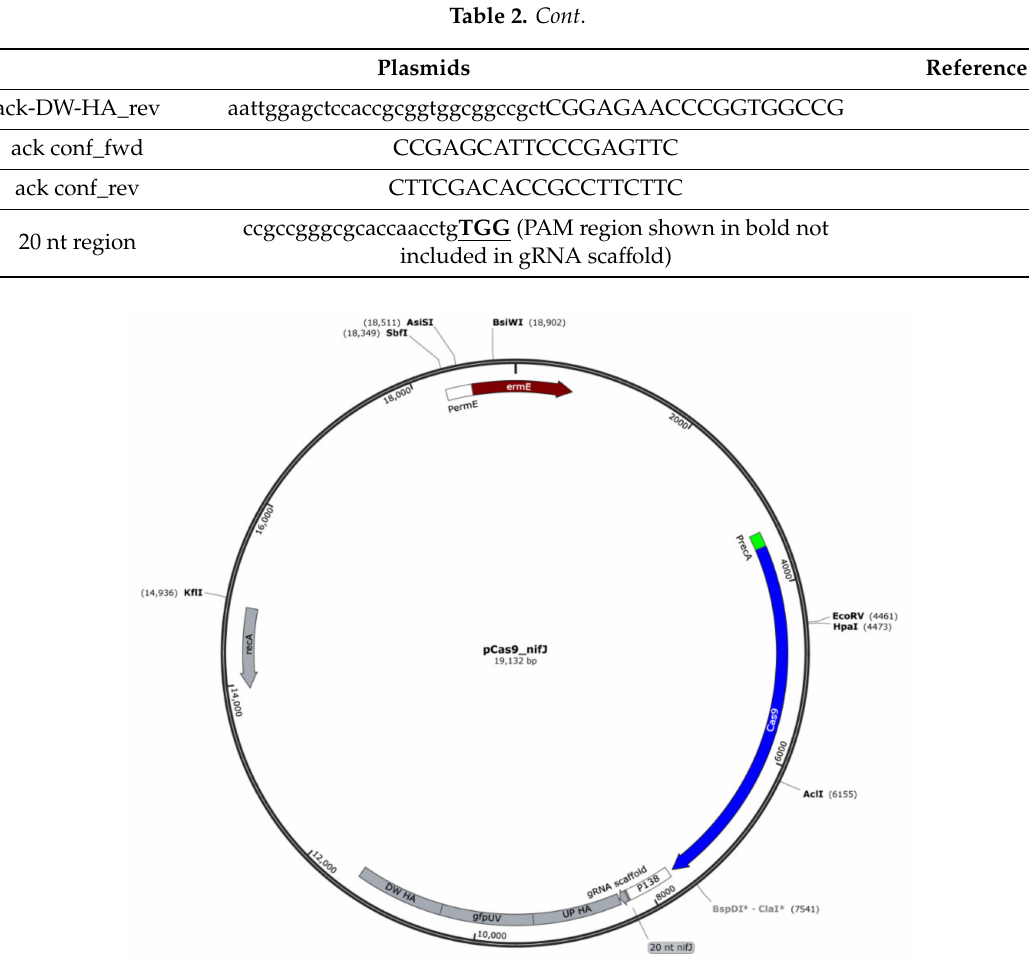
Figure 2. Plasmid map for pCas9_nifJ. Knockout is driven by recombination between downstream and upstream homologous arms (DW HA and UP HA, respectively) and the nifJ1 gene in the chromosome, leading to disruption of the nifJ1 with